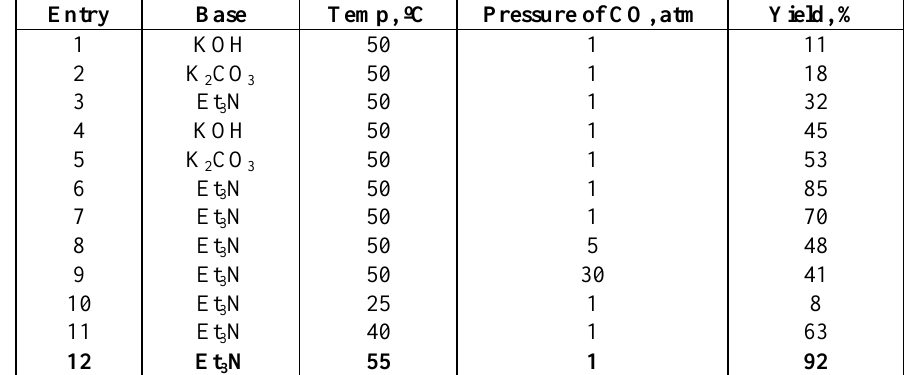
Table 3. Methoxycarbonylation of aryl iodides catalyzed by polymer-supported palladium.